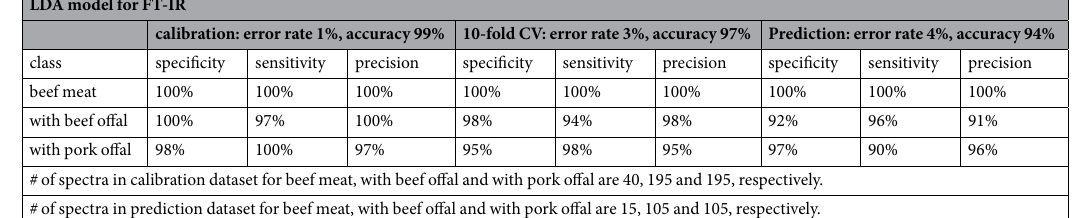
Table 2. The optimized models for the 3-class classification of FT-IR spectral